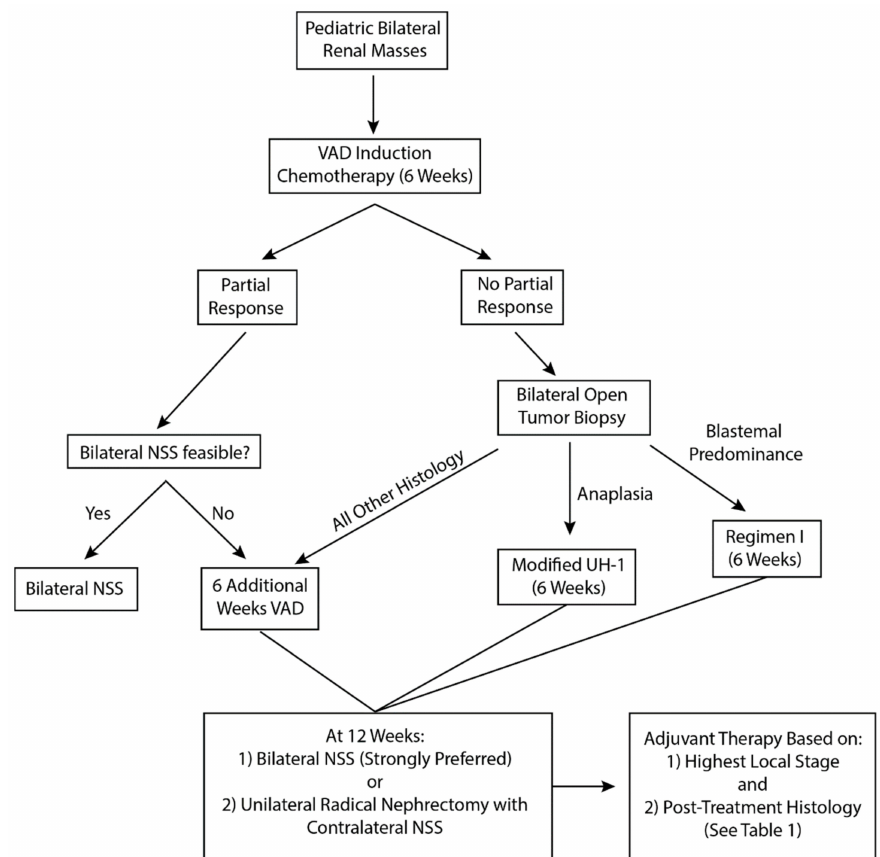
Figure 2. Surgical management algorithm for bilateral Wilms tumor. NSS—Nephron-sparing surgery; VAD—vincristine, actinomycin-D, doxorubicin; Revised UH-1—vincristine, dactinomycin, doxorubicin, cyclophosphamide, carboplatin, etoposide; Regimen I—vincristine, dactinomycin, doxorubicin, cyclophosphamide,